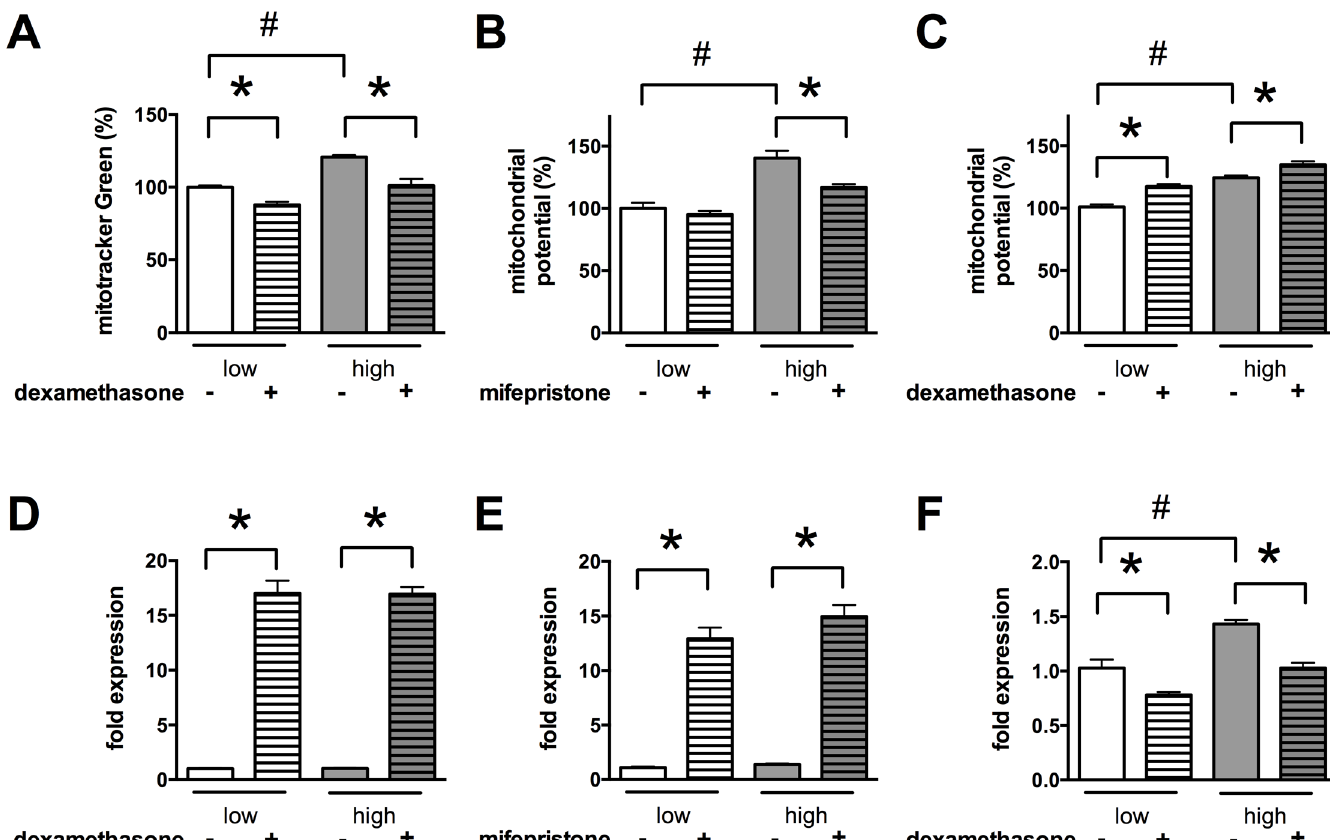
Fig 4. Glucocorticoid steroids block the glucose-induced mitochondrial hyperpolarization and induce UCP2 expression. A, B, D, E: b.End3 endothelial cells were exposed to high glucose for 7 days and treated with the dexamethasone (1 μ M) or mifepristone (3 μ M) for 3 days. A, B: Changes in the mitochondrial potential were determined by measuring the MitoTracker Green uptake ( A ) or the ratio of the mitochondrial J-aggregate and the free cytoplasmic form of JC-1 ( B ). C, F : EA.hy926 human venous cells were exposed to high glucose for 7 days and treated with dexamethasone (1 μ M) for 3 days. C : The mitochondrial membrane potential was measured by JC-1 dye. D, E, F : UCP2 expression was determined by realtime PCR using Taqman assays. (#p < 0.05 high-glucose exposure induced significant changes compared to cells maintained in low glucose containing medium, * p < 0.05 glucocorticoid treatment induced significant